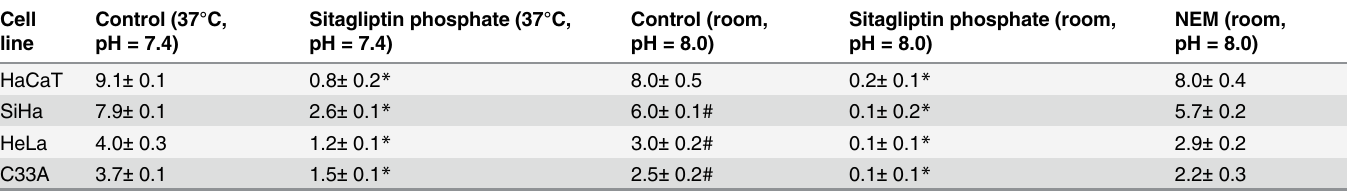
Gly-Pro-p-nitroanilide hydrolysis was measured in immortalized keratinocytes (HaCaT) and in human cervical cancer cell lines (SiHa, HeLa and C33A) as described in Material and Methods. Mean values ± S.D is expressed in speci fi c activity (nmol of p-nitroaniline liberated/min/mg of protein). The values are representative of three different experiments. * Indicates statistical signi fi cance when the sitagliptin phosphate and NEM groups were compared to the respective control group. # Indicates statistical signi fi cance when controls were compared, indicating the effect of pH and temperature. ANOVA followed by Tukey ’ s test, p (cid:1)